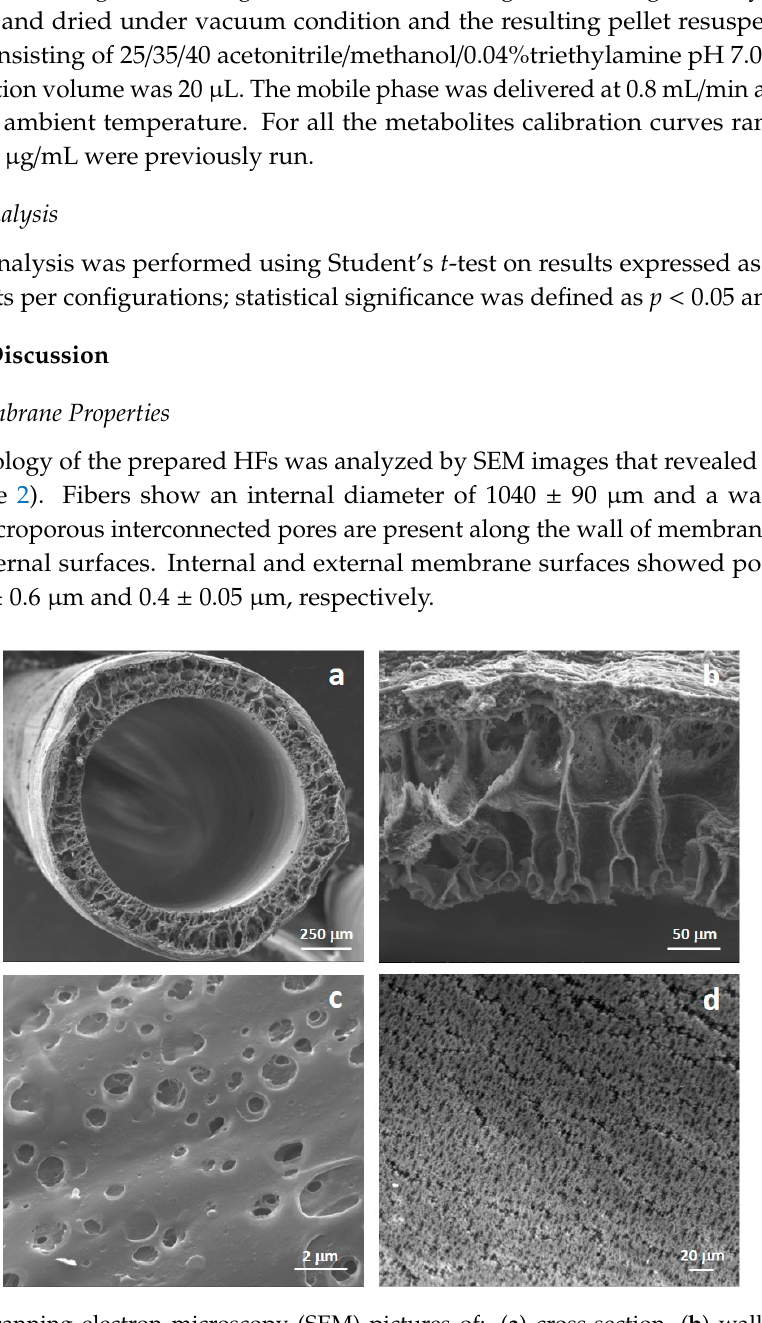
Figure 2. Scanning electron microscopy (SEM) pictures of: ( a ) cross-section, ( b ) wall thickness, ( c ) extracapillary surface, and ( d ) lumen surface of PCL HF membranes.